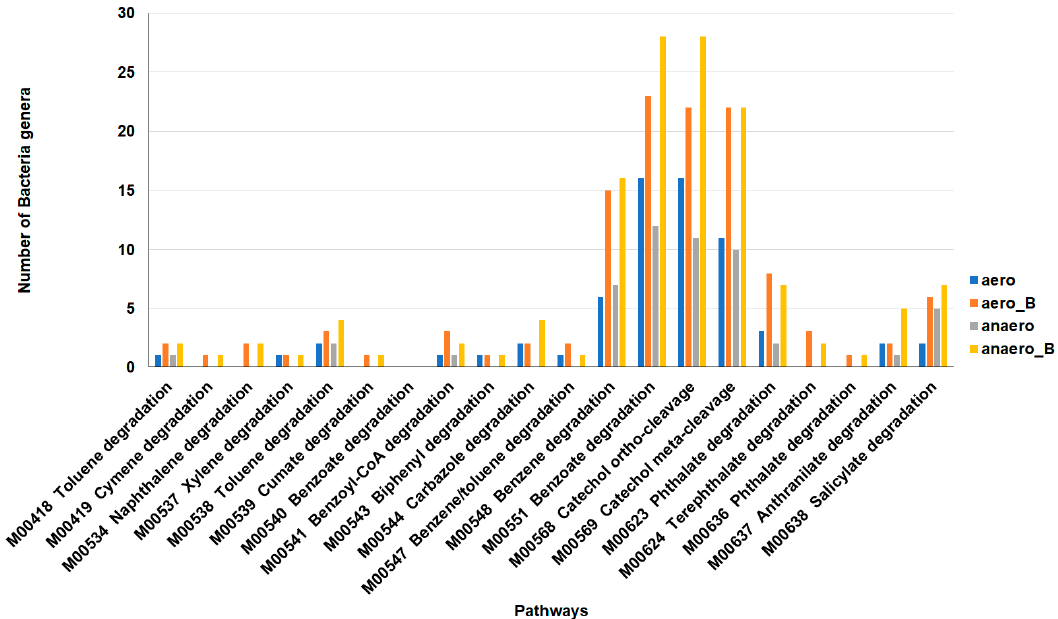
Figure 8. Xenobiotic biodegradation-associated microbial genera after the 3rd repeated addition experiment under aerobic and anaerobic conditions. Mxxxxx are Kyoto Encyclopedia of Genes and Genomes (KEGG) database module IDs. aero: sludge under aerobic conditions. anaero: sludge under anaerobic conditions. aero_B: sludge with antibiotic-degrading bacteria under aerobic conditions. anaero: sludge with antibiotic-degrading bacteria under anaerobic conditions.